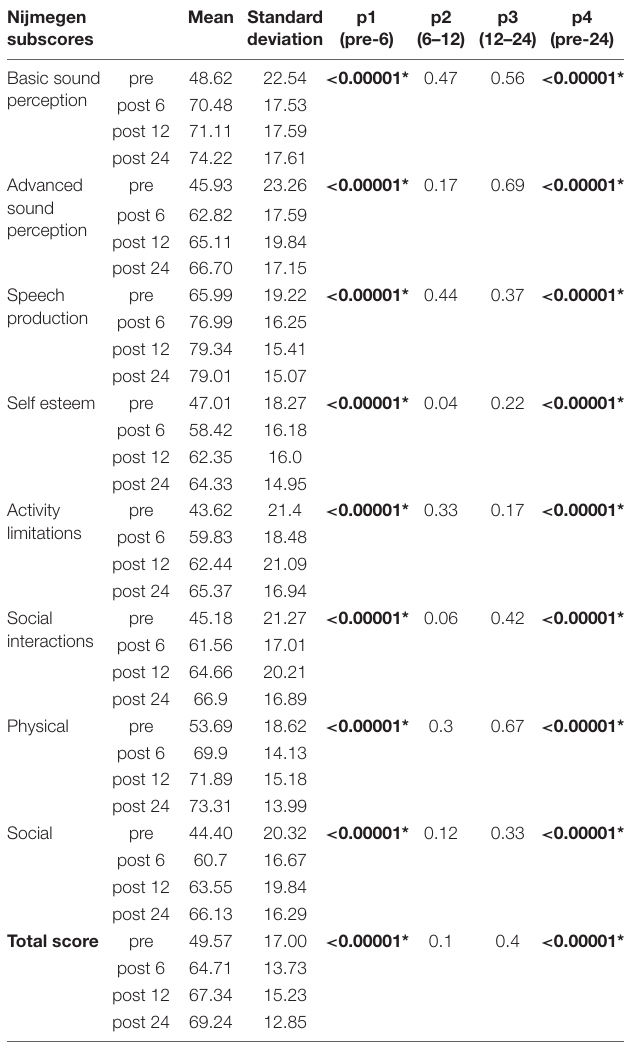
TABLE 3 | Mean score of the Nijmegen Cochlear Implant